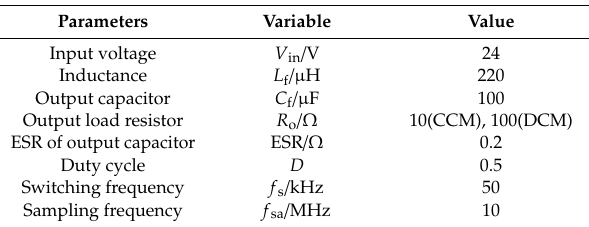
Table 1. Simulation Parameters of Buck